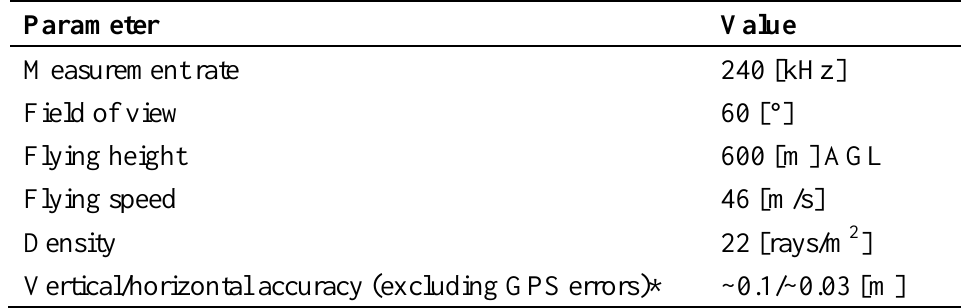
Table 2. Flight and system parameters of the flight campaign in summer 2009 with the ―Harrier 56‖ LiDAR system (AGL = above ground level).